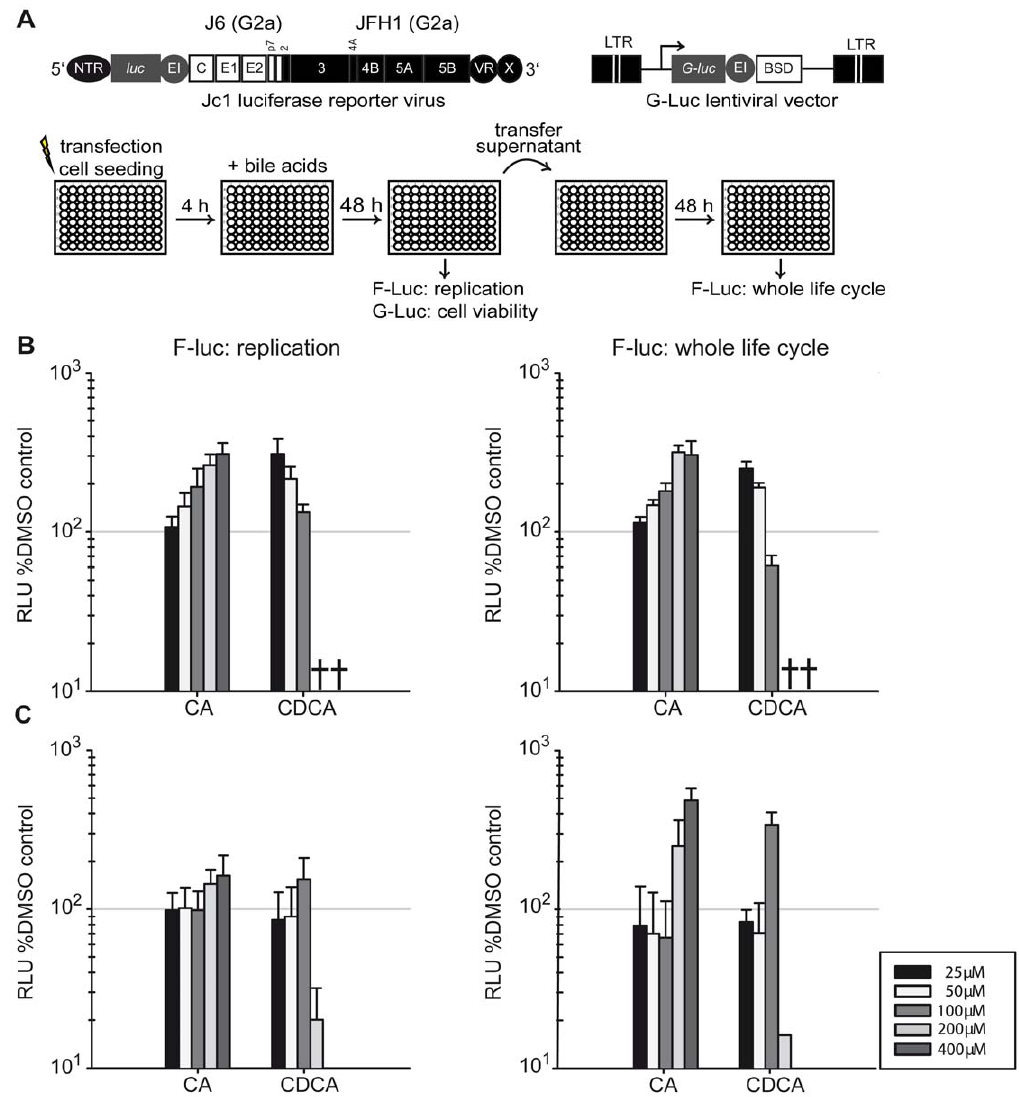
Figure 2. Influence of bile acids on HCV whole life cycle. A: Experimental setup and schematic drawing of the Luc-Jc1 reporter virus genome carrying a firefly luciferase gene and of the gaussia luciferase construct. Lunet G-luc cells were transfected with the chimeric full-length reporter virus genome and seeded on a 96-well plate. 4 h post-electroporation the medium was removed and new medium containing bile acids was added. After 48 h, RNA-replication in the transfected cells was determined by firefly luciferase assays. At the same time, culture fluid of the cells was collected to determine cell viability through G-luc activity and to inoculate naı¨ve Lunet G-luc cells. 48 h later efficiency of virus production and infection was determined by measuring firefly luciferase in the inoculated cells. B: RNA-replication (left) and virus production/infection (right) in the presence or absence of given doses of BAs determined in Lunet G-luc cells. Replication and whole life cycle data were normalized to DMSO control. The symbol { designates concentrations with a cell viability of less than 50% of the DMSO control. C: Analysis of the influence of given BA doses on Luc-Jc1 replication in HuH6 cells (left) and on the infectivity of secreted particles upon inoculation of Lunet G-luc cells. Means values of triplicates and the standard deviation is